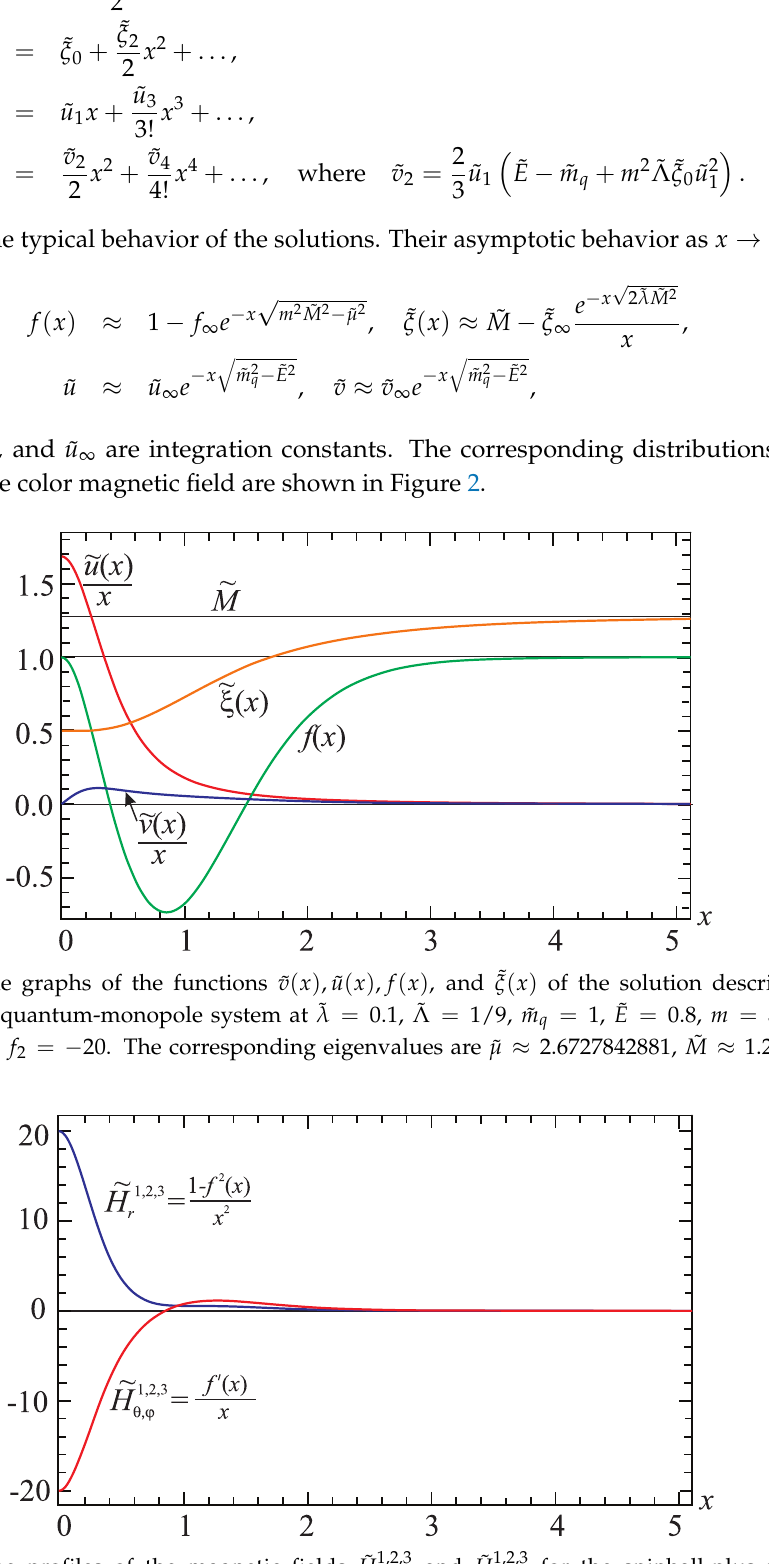
for the spinball-plus-quantum- θ , ϕ